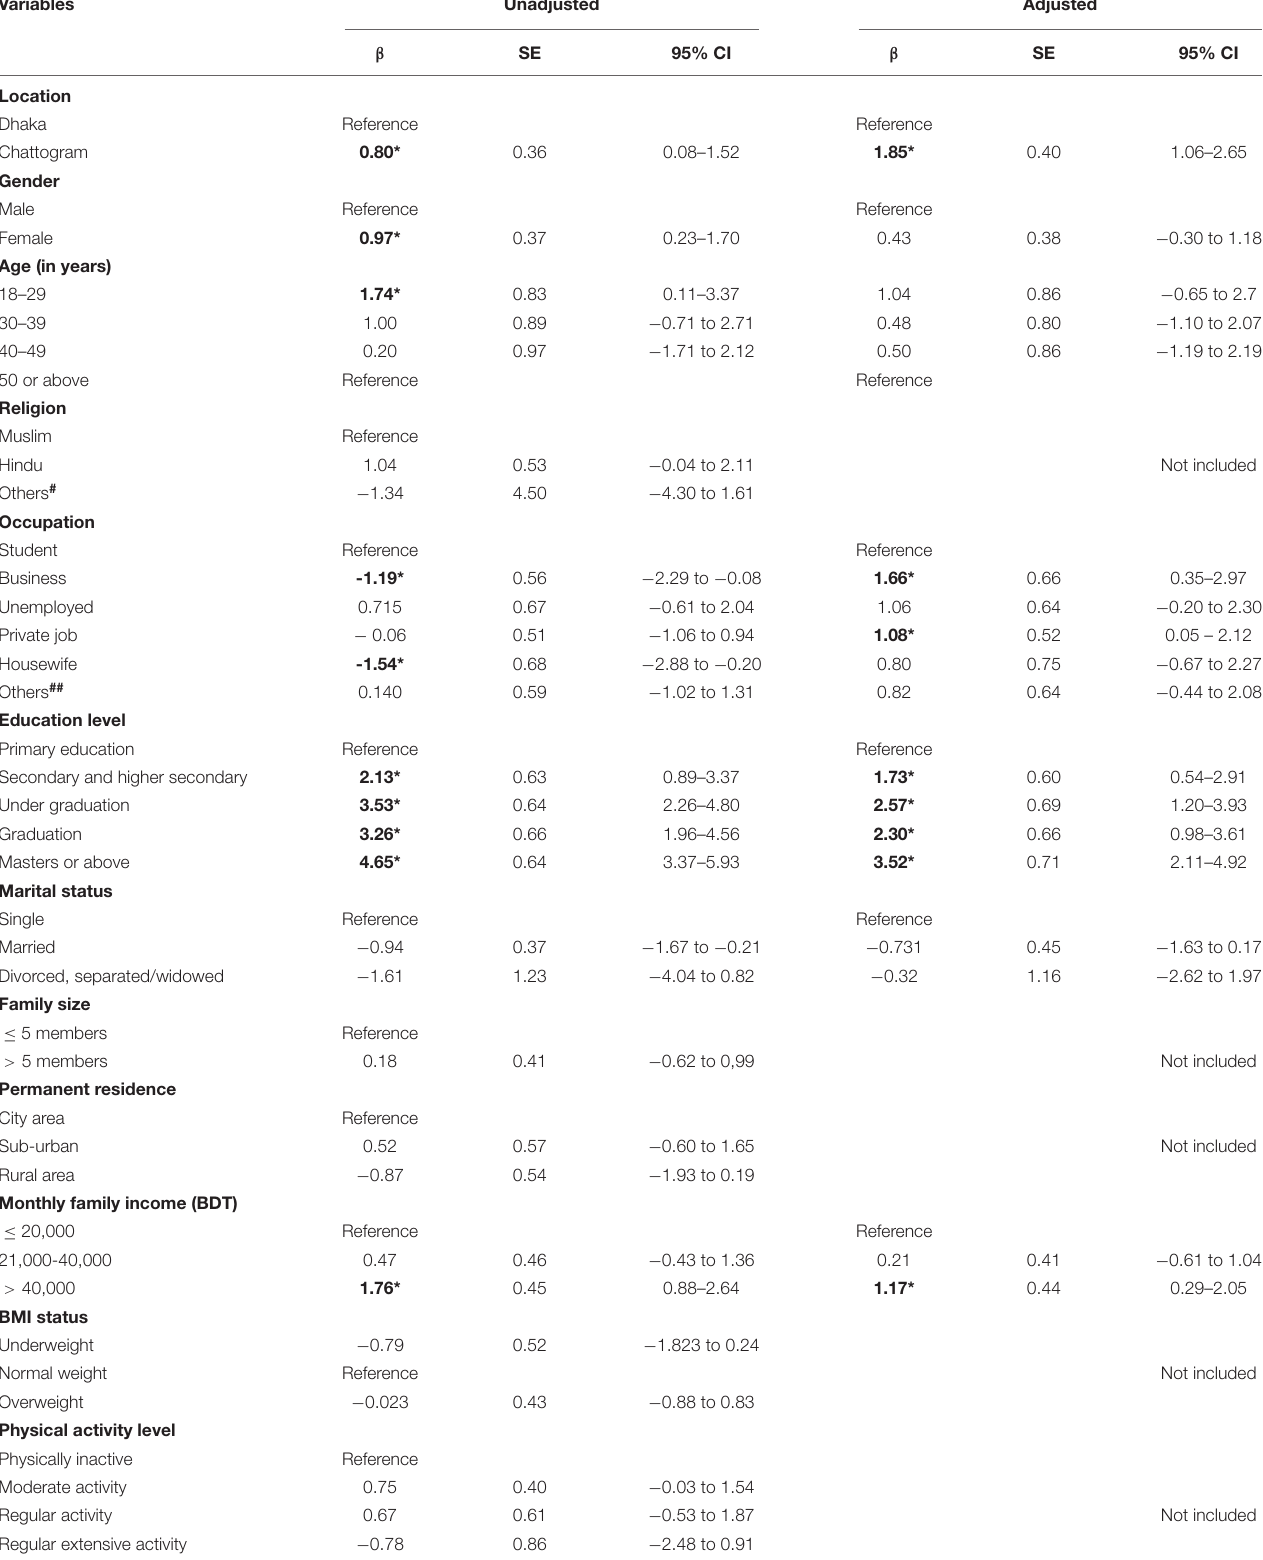
TABLE 2 | Multiple linear regression showing the factors associated with nutrition literacy among Bangladeshi adults ( N = 400).